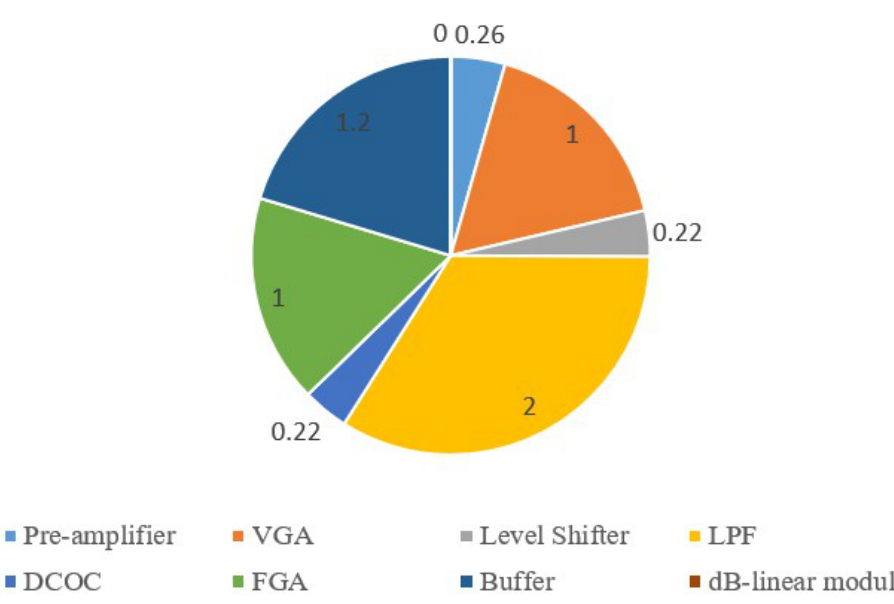
Figure 17. Powerconsumptionpiechart. Figure 17. Power consumption pie chart. (dB-linear module working in lowest power consumption mode).